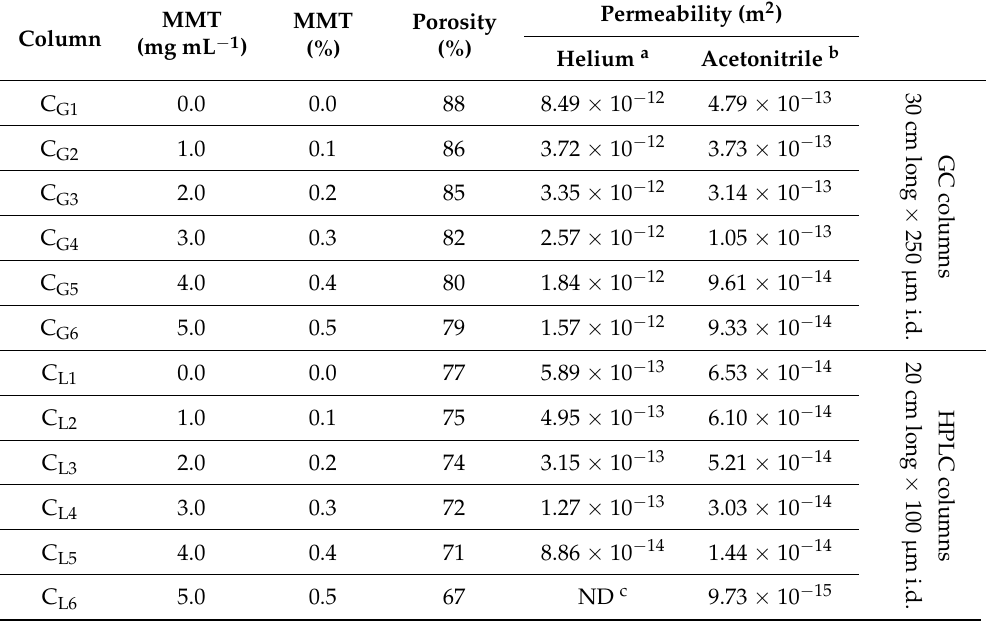
Table 1. MMT content of the prepared columns. Porosity and permeability values of the prepared capillary GC and HPLC columns. MMT MMT Column (mg mL − 1 ) (%)